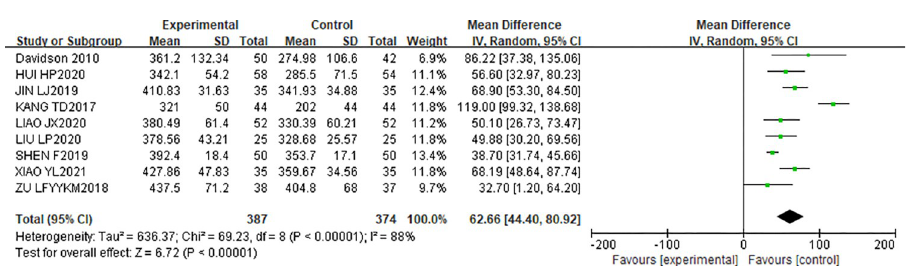
Fig 6. Influence of CR on 6MWT of patients.